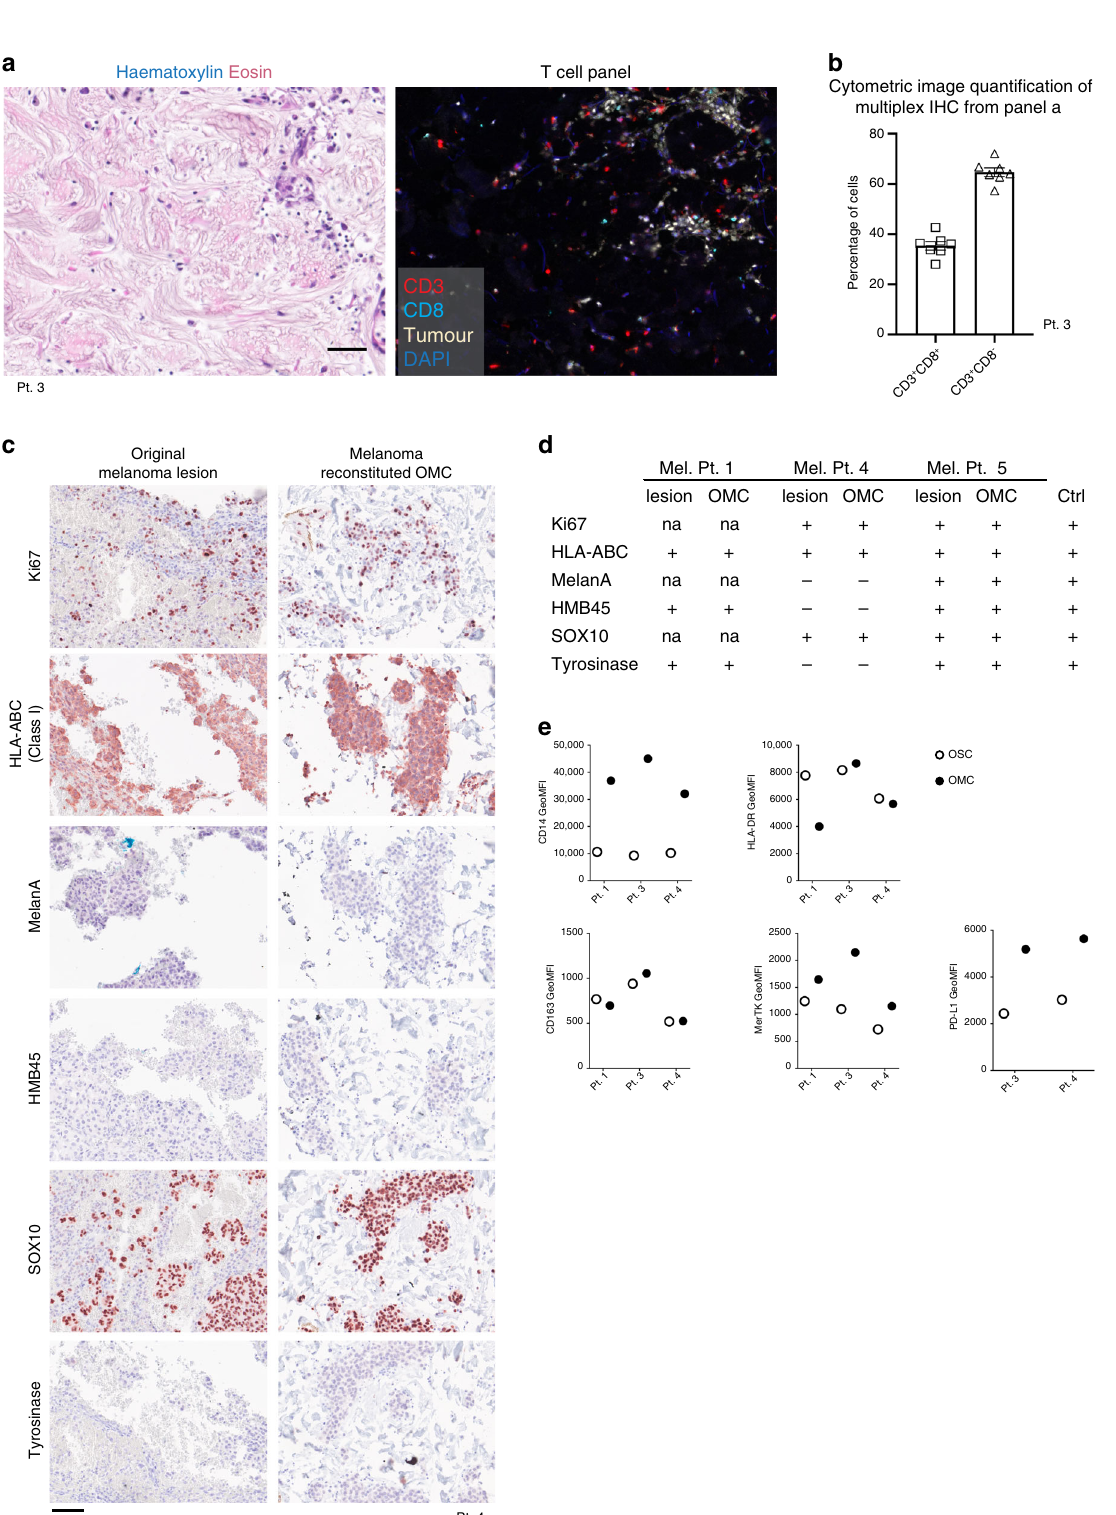
CD1c, anti-CD14 and anti-CD20 Abs (Supplementary Table 1). Purity levels higher than 96% were achieved, determined by fl ow cytometry (Supplementary Fig. 6a). For live imaging experiments, cDC2s were pre-labelled with the membrane dye PKH26 (Sigma-Aldrich) according to manufacturers ’ protocols and resuspended in X-VIVO-15 medium (Lonza), supplemented with 2% human serum (HS, Sanquin). Autologous or allogeneic CD3 + T cells used in T-cell co-culture experiments were isolated using the Pan T-cell isolation kit (Miltenyi Biotec) following the manu- facturer ’ s instructions. Peripheral blood monocytes were isolated using CD14- MACS Microbeads (Miltenyi Biotec) according manufacturer ’ s